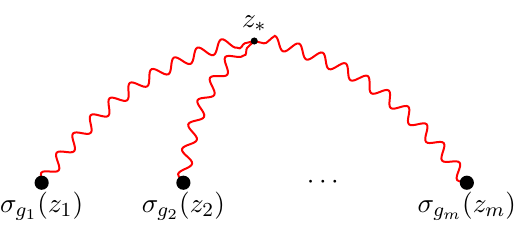
Figure 2 . The choice or the branch cuts in the correlator h (cid:27) g